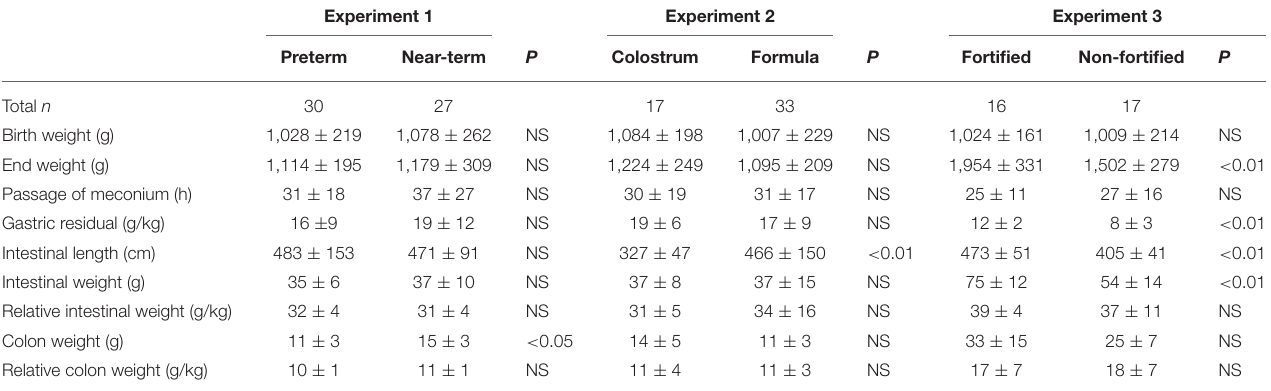
TABLE 1 | Clinical